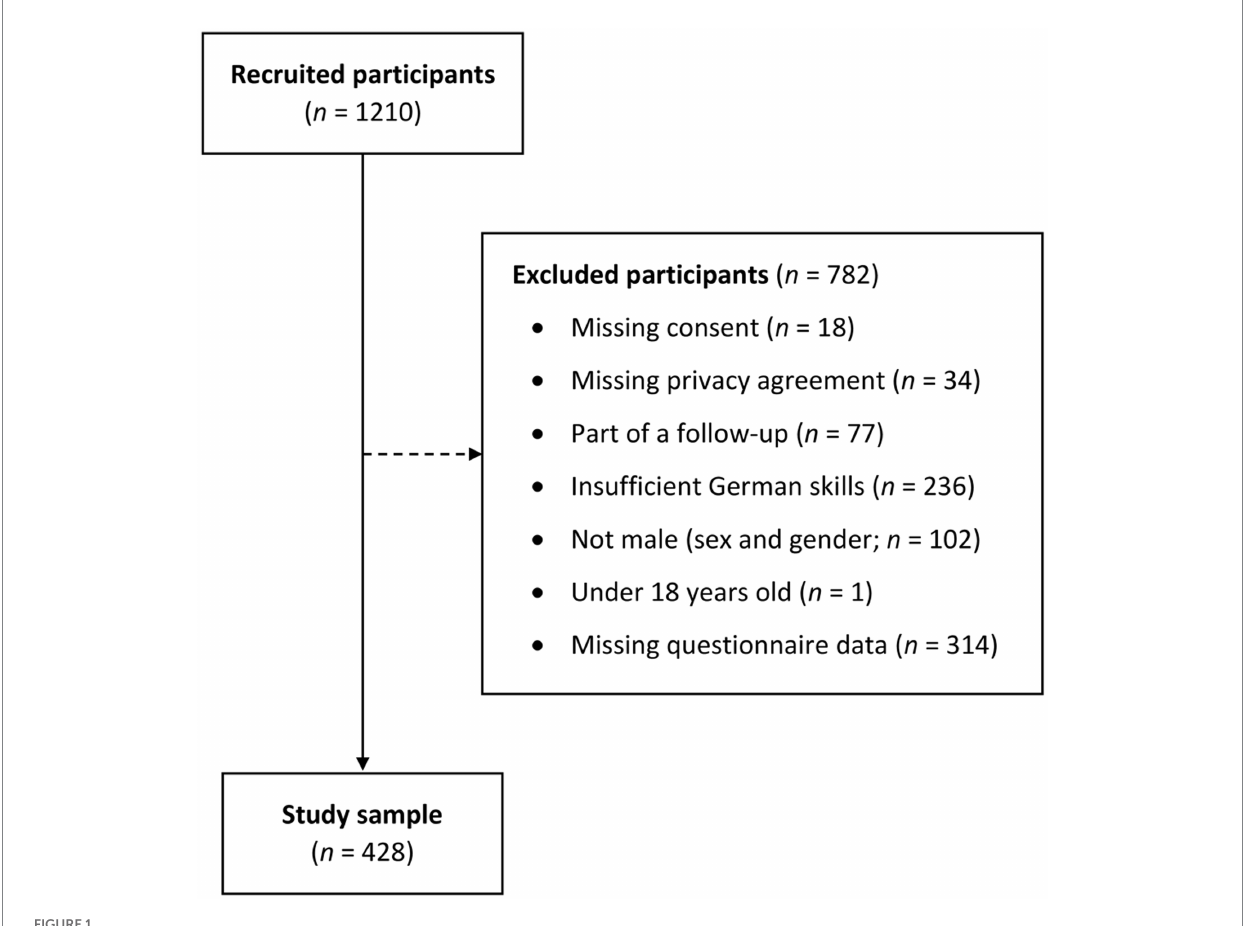
FIGURE 1 Overview of the exclusion process. n = Number of